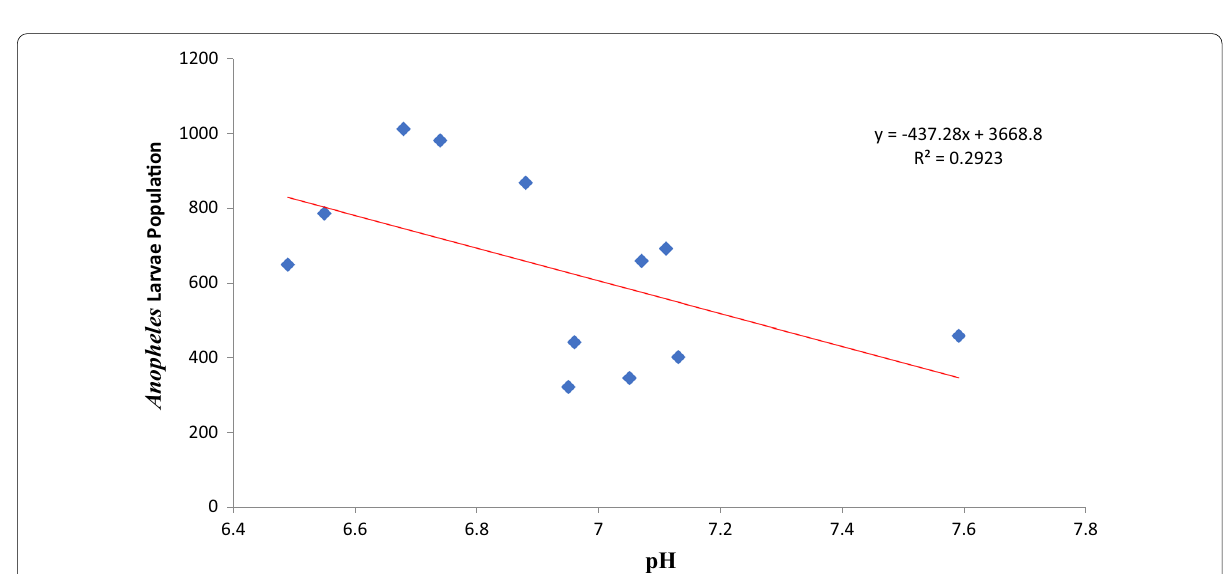
y = -437.28x + 3668.8 R² = 0.2923